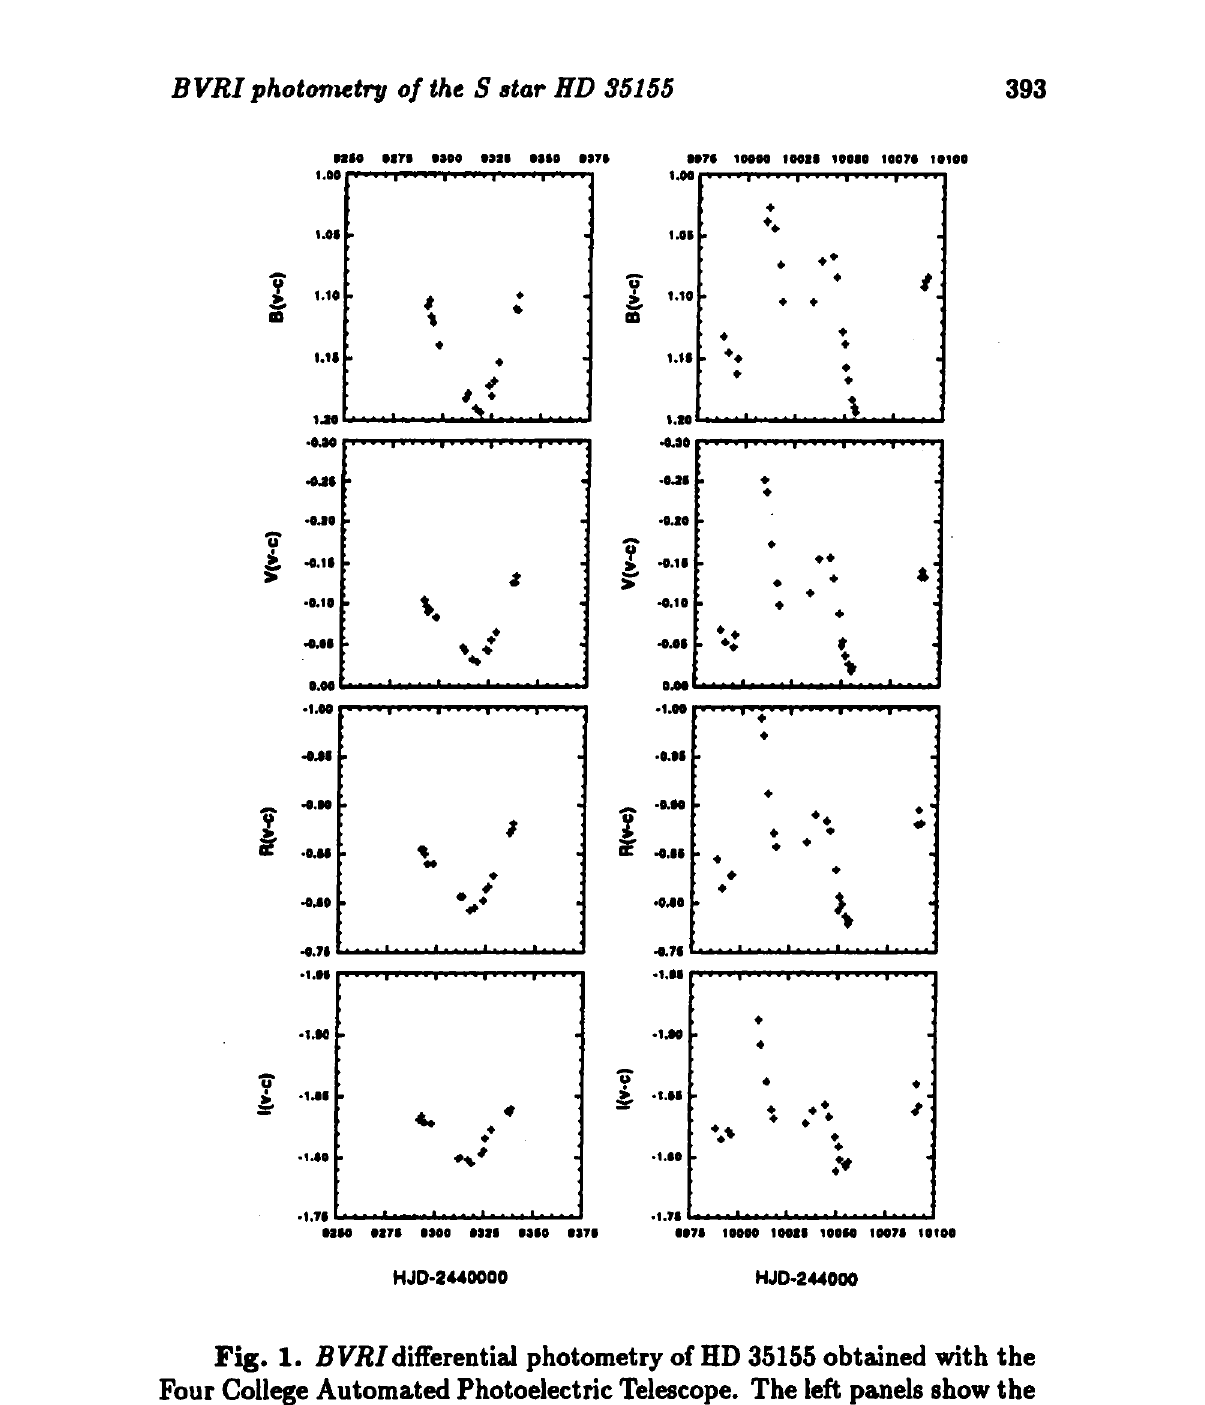
Fig. 1. BVRI differential photometry of HD 35155 obtained with the Four College Automated Photoelectric Telescope. The left panels show the values obtained during the 1993-94 observing season and the right panels show the values from the 1995-96 season. Phase 0.00 occurs at HJDs 2449436 and